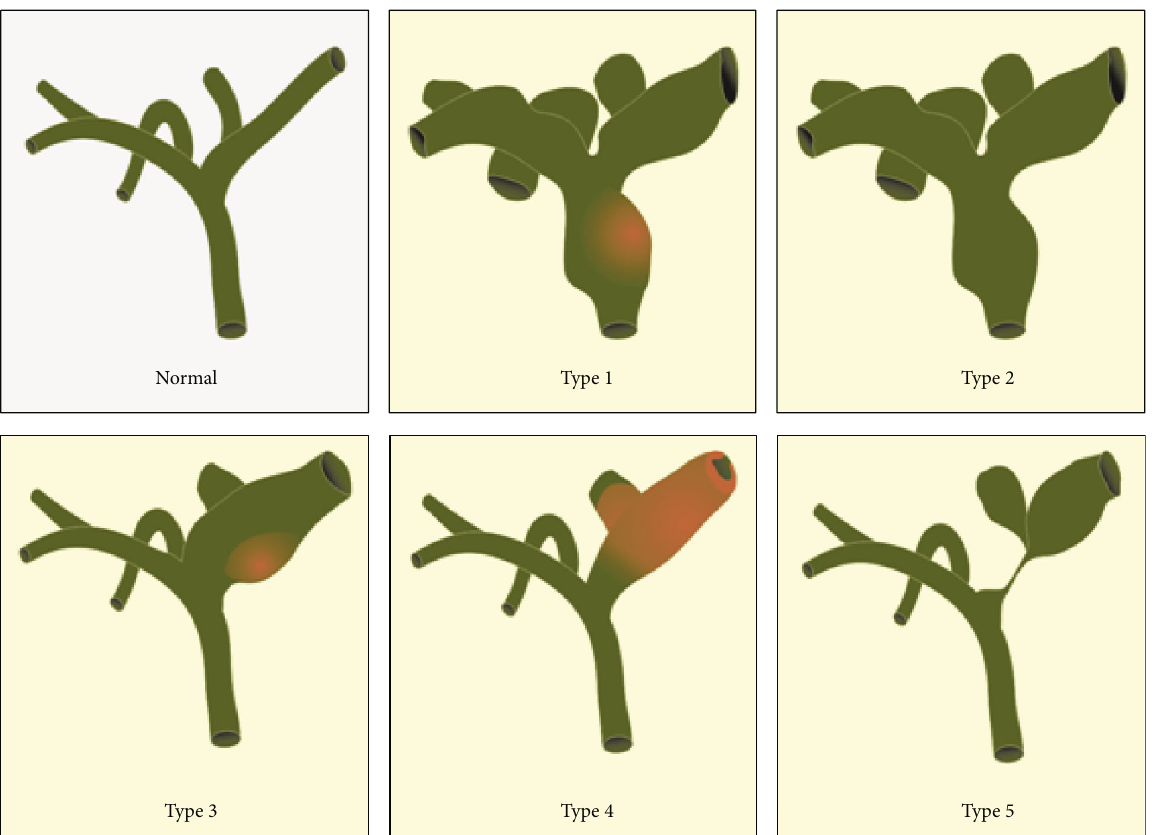
Figure 3: Anatomical classi fi cation of intraductal papillary neoplasms of the bile duct ( fi gure based on Wan XS, WJG